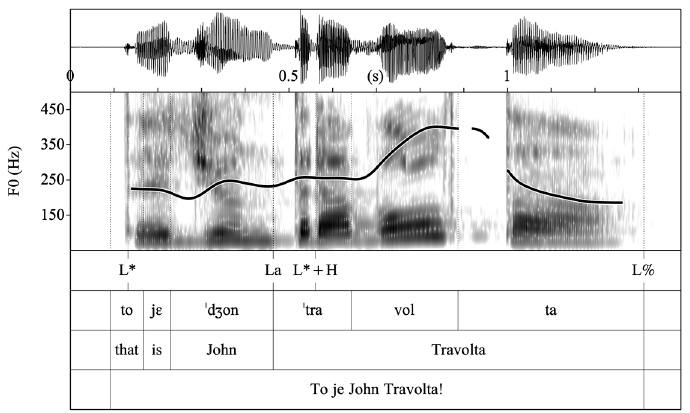
Figure 2. Waveform, spectrogram and F0 trace of the non-neutral statement of the obvious It is John Travolta! in L1 Czech produced with L*+H L%.